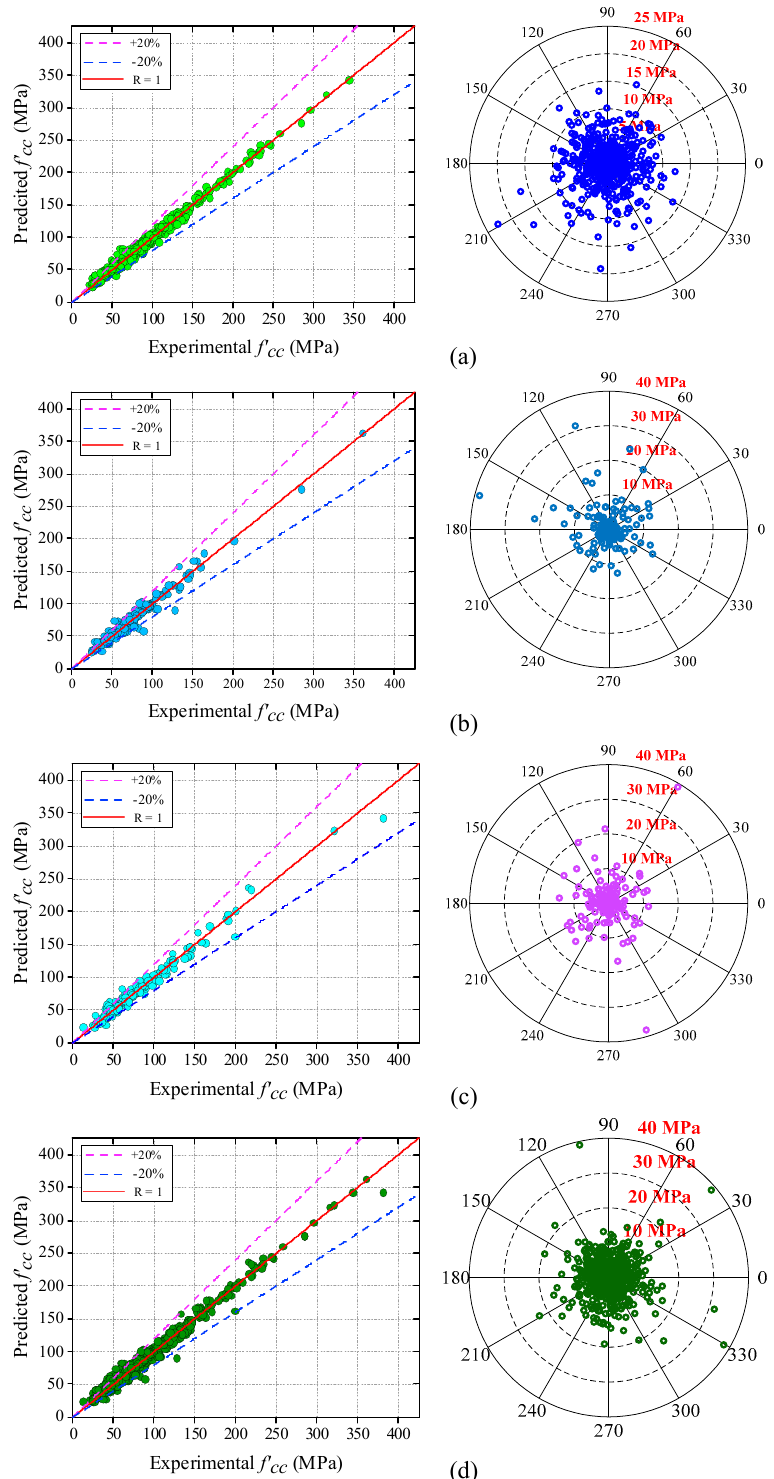
Figure 8. Scatter and absolute error plot of ANN model; ( a ) training, ( b ) validation, ( c ) testing, and ( d ) whole